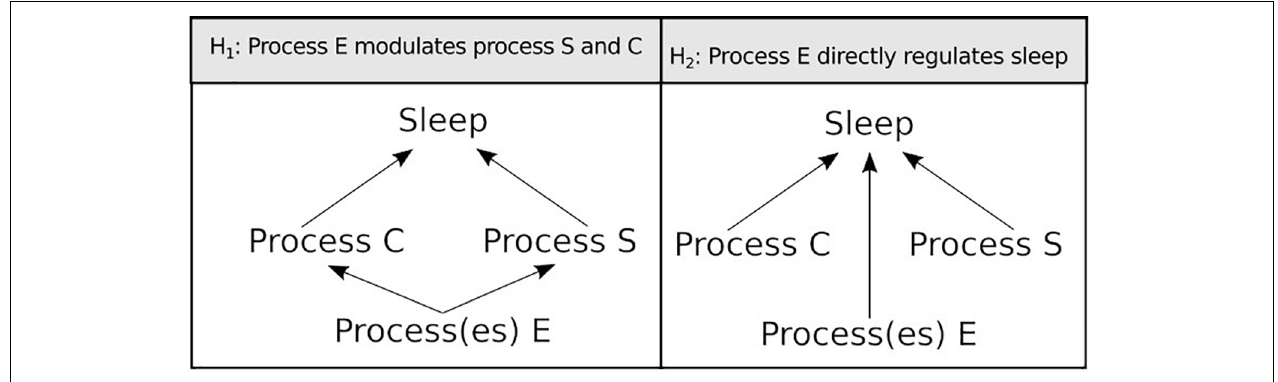
FIGURE 4 | Two alternative hypotheses on how environmental factors can be integrated into the Borbély (1982) model of sleep regulation.